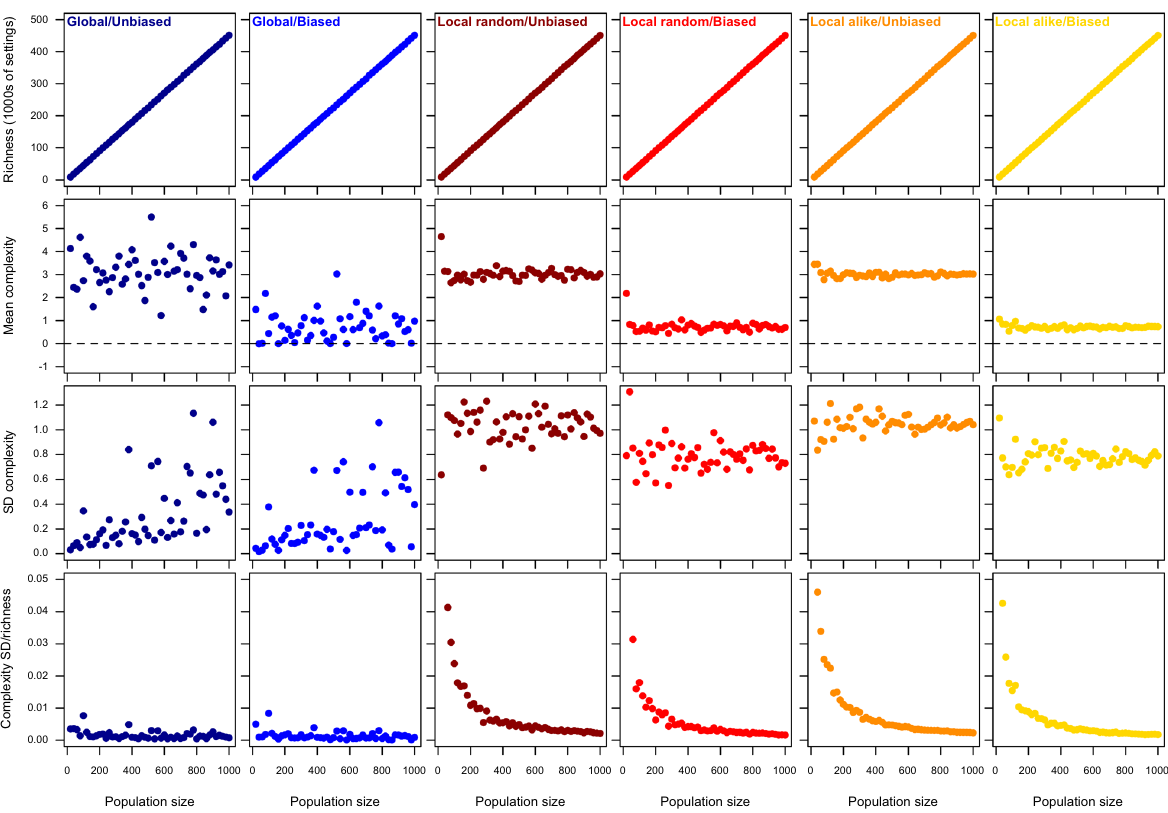
Fig. 4 Scatterplots illustrating effects of population size on tune diversity and complexity across simulation conditions. Scatterplots illustrating the relationship between population size and richness (1000 s of unique settings), mean complexity, SD complexity and SD complexity relative to (divided by) richness, across the six simulation conditions: global populations with unbiased copying, global populations with intermediate-biased copying, randomly selected local populations with unbiased copying, randomly selected local populations with intermediate-biased copying, assortatively selected local populations with unbiased copying and assortatively selected local populations with intermediate-biased copying.